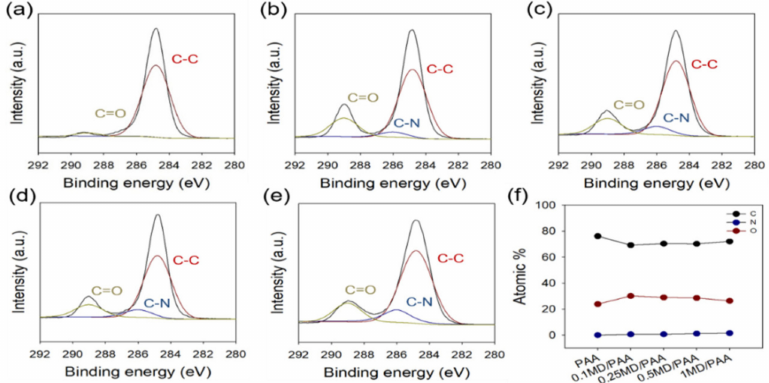
Figure 6. XPS spectra (C1s) of MD contained poly(acrylic acid) hydrogel films: ( a ) PAA, ( b ) 0.1MD / PAA, ( c ) 0.25MD / PAA, ( d ) 0.5MD / PAA, ( e ) 1MD / PAA (irradiated at 25 kGy), and ( f ) relative composition of carbon, nitrogen, and oxygen atoms.